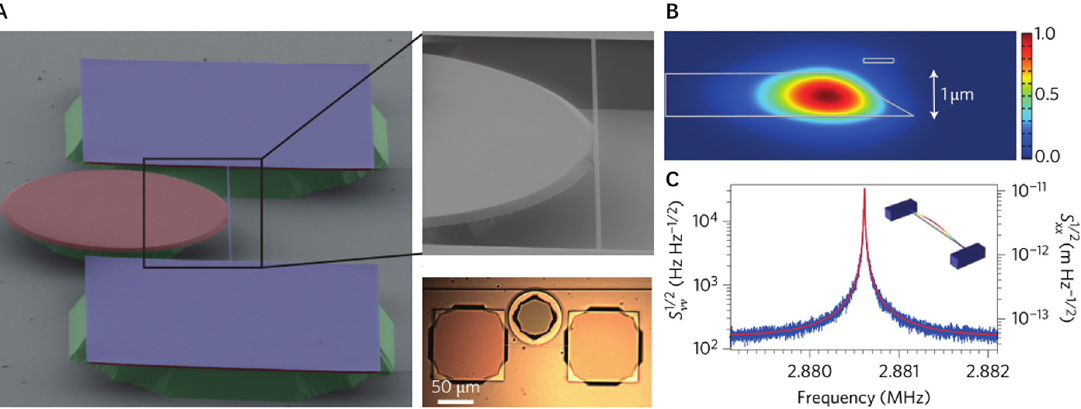
Figure 12: (A) SEM image of an integrated hybrid force detection system base on a microdisk cavity coupled with nanomechanical beam. Top right: enlarged picture of the adjacent area. Bottom right: optical micrograph of the hybrid system coupled with a tapered fiber. (B) Finite-element simulation of electric field distribution in the microdisk cavity. (C) Frequency noise units and displacement density units as a function of frequency. Finite-element simulation of the fundamental vibration mode of the beam is shown in the inset